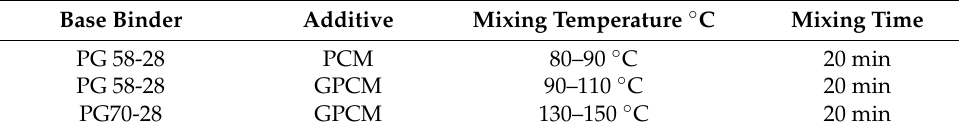
Table 5. Binder preparation temperatures/mixing time for different